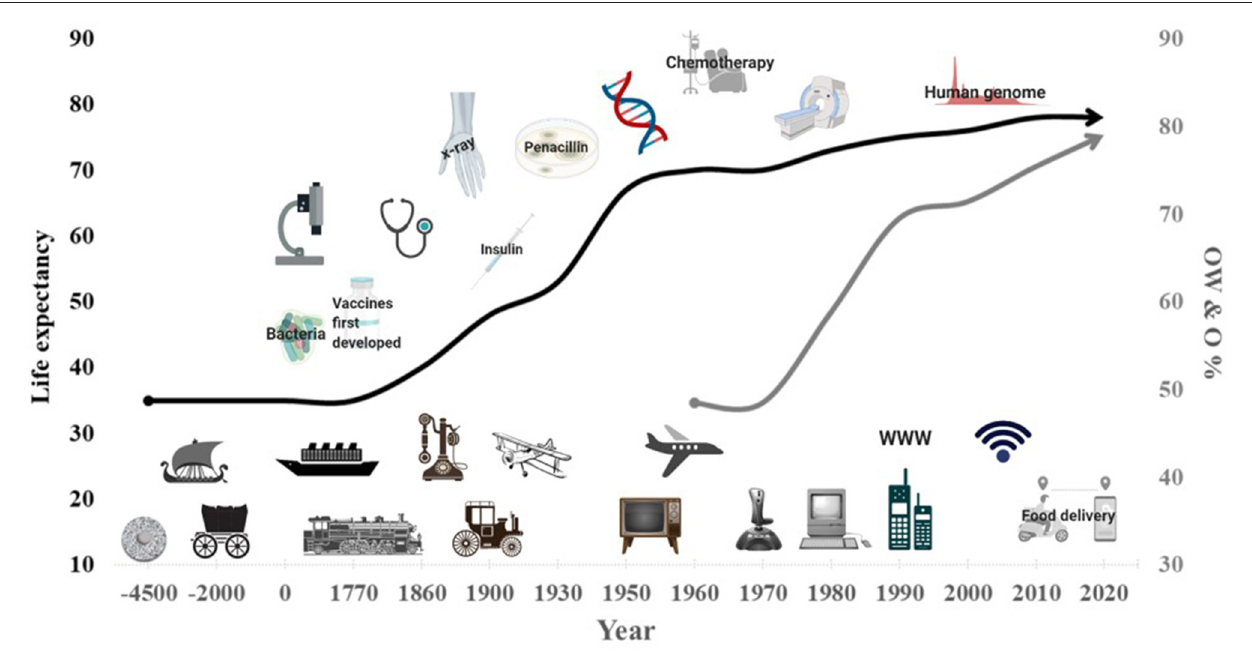
FIGURE 1 | Increase in life expectancy (black line) and in overweight and obesity trends (OW and O, grey line) with advanced in technology and medical treatments. Created with